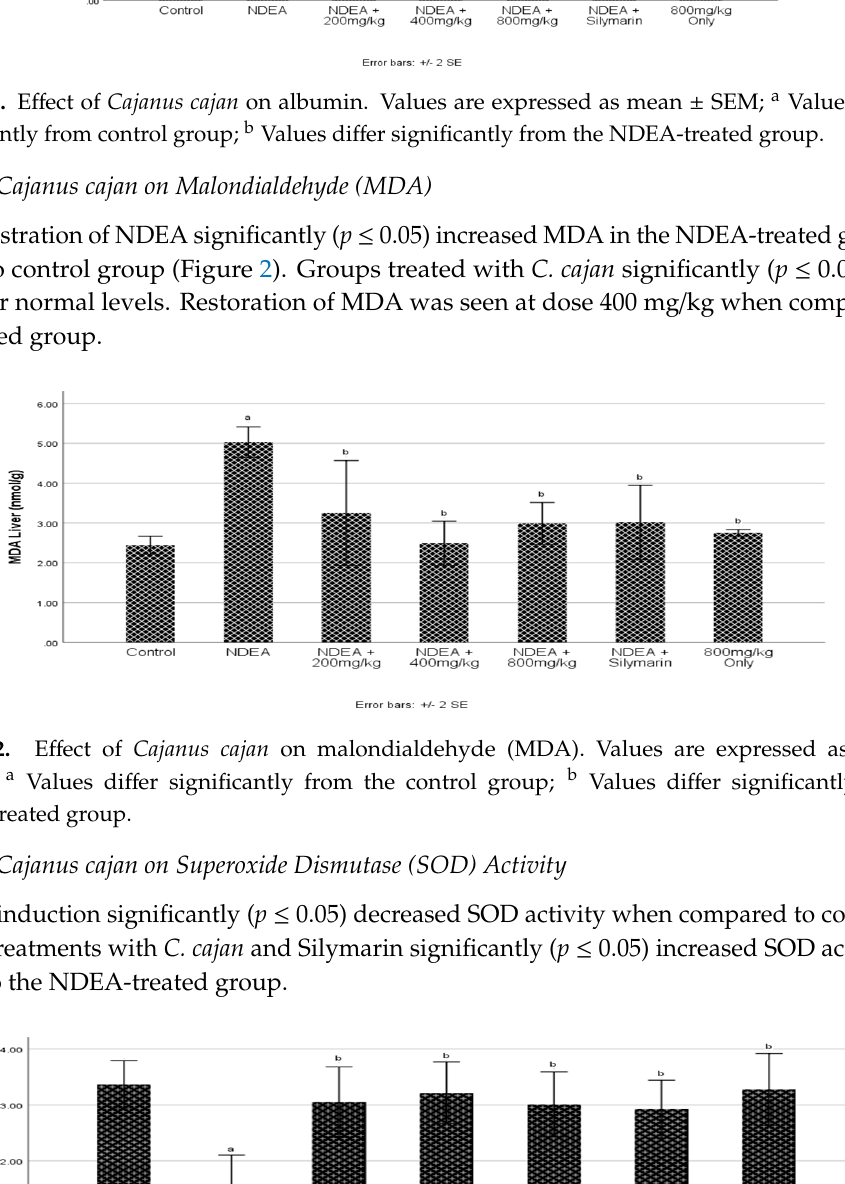
Figure 3. Effect of Cajanus cajan on superoxide dismutase (SOD) activity. Values are expressed as mean ± SEM; a Values differ significantly from the control group; b Values differ significantly from the NDEA-treated group.